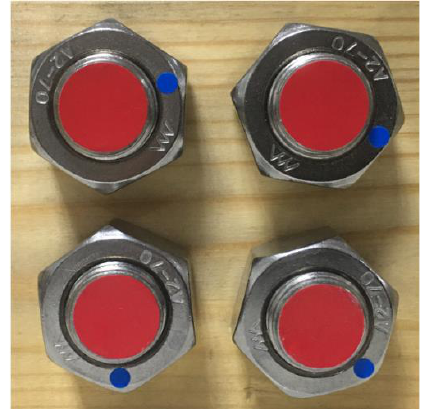
Figure 14. Four-bolted connection.